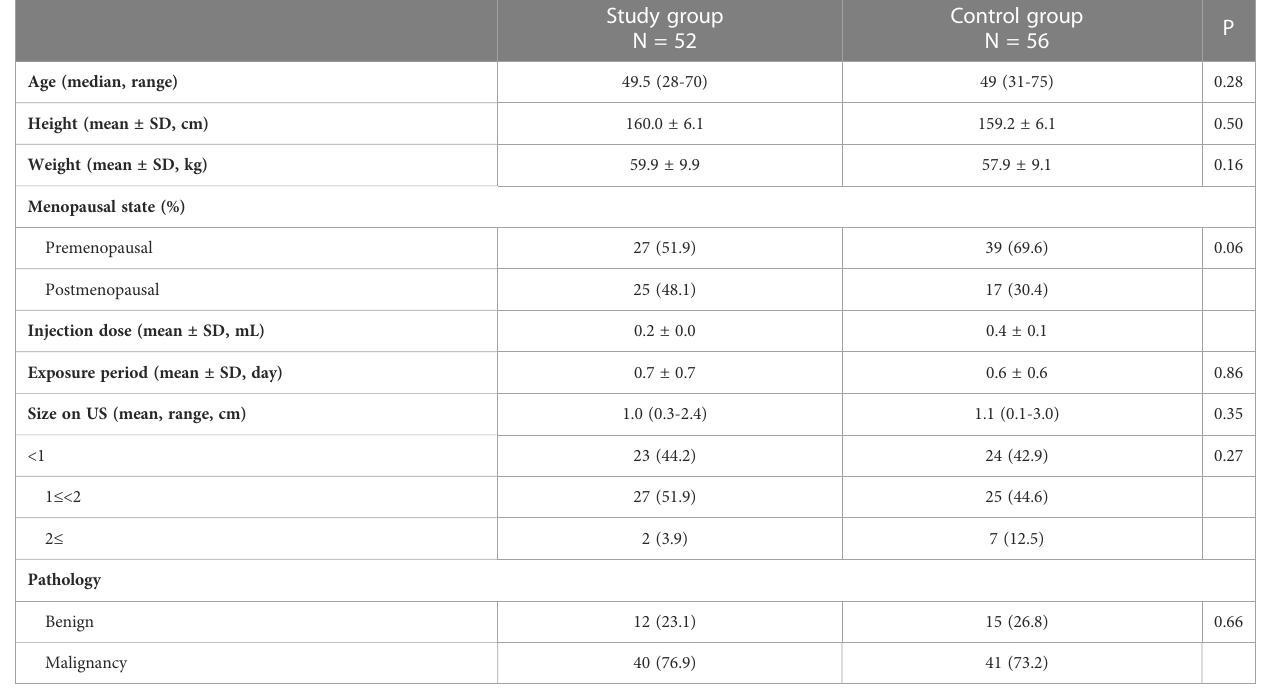
TABLE 2 Baseline characteristics of included